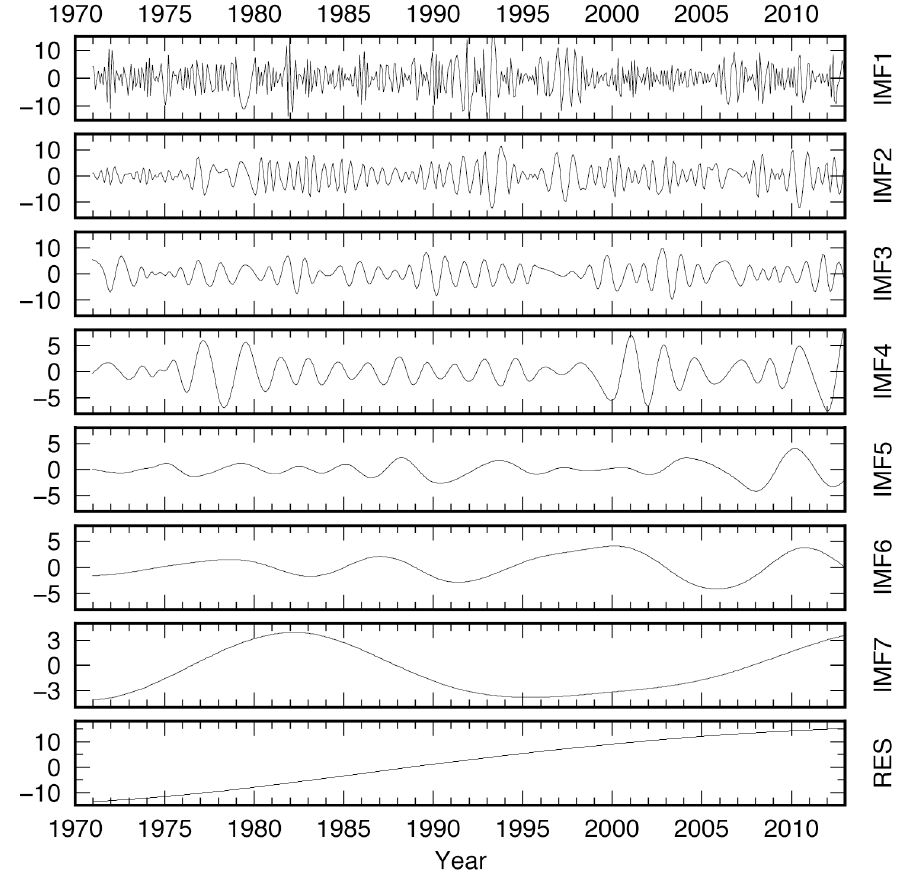
Figure 5. Results of the EMD analysis of the Marina di Ravenna relative sea-level time series since 1970, with the IMFs in the top frames and the residual (RES) in the bottom, respectively. Units are cm